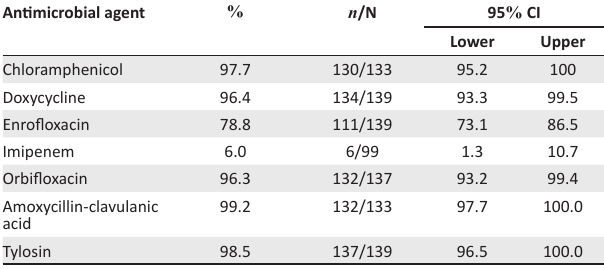
TABLE 2: Proportions of various antimicrobials that were involved in the multi-drug resistance combinations. Antimicrobial